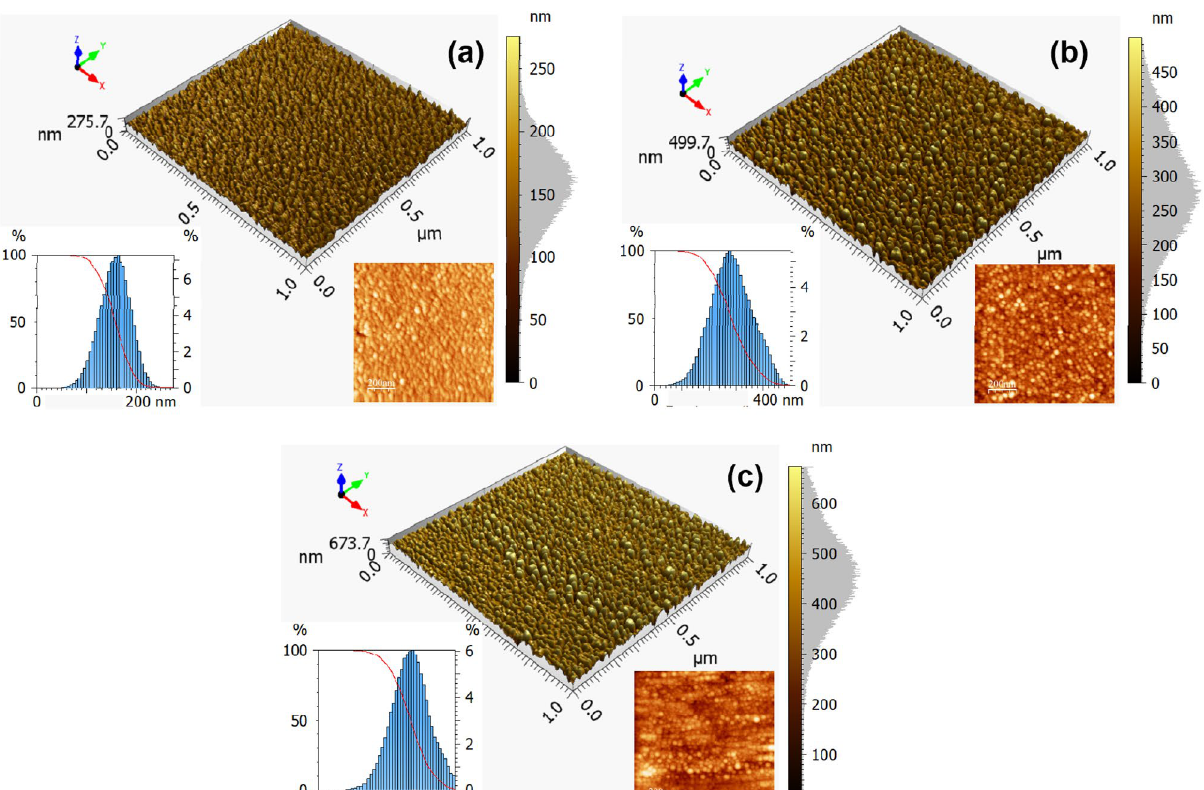
Figure 2. AFM maps of ( a ) Cu, ( b ) CuNi15, and ( c ) CuNi20 thin films. Their respective 2D maps, height distribution, and Abbott firestone curves are inset in each